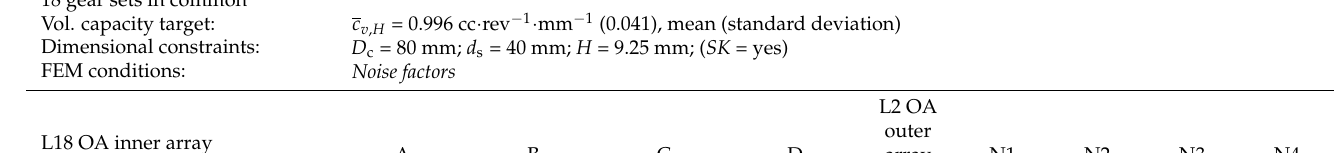
Table 7. The parameter design table of the fourth Taguchi experiment. (Please refer to Nomenclature section and Figure